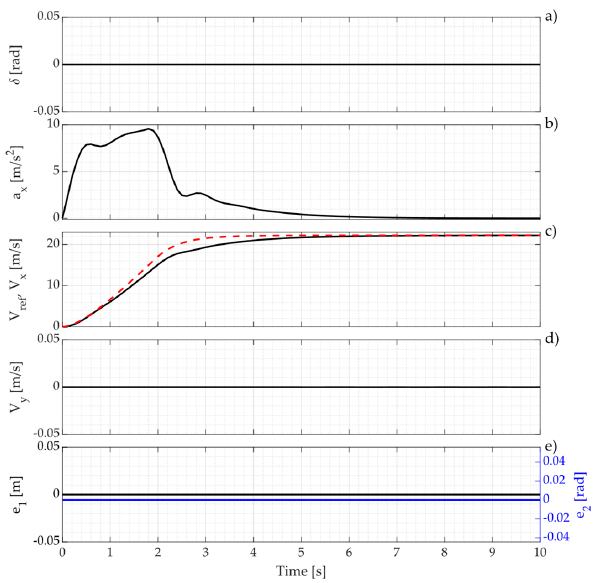
Figure 11. Results obtained for the straight road portion in MIL configuration (see Figure 8). Mea- sured vehicle states: ( a ) Front wheels steering angle δ ; ( b ) Longitudinal acceleration a x ; ( c ) Longitu- dinal speed reference V ref (red, dashed) vs. Actual longitudinal speed V x (black, solid); ( d ) Lateral speed V y ; ( e ) Cross track e 1 (black, solid) and Relative yaw angle e 2 (blue, solid).